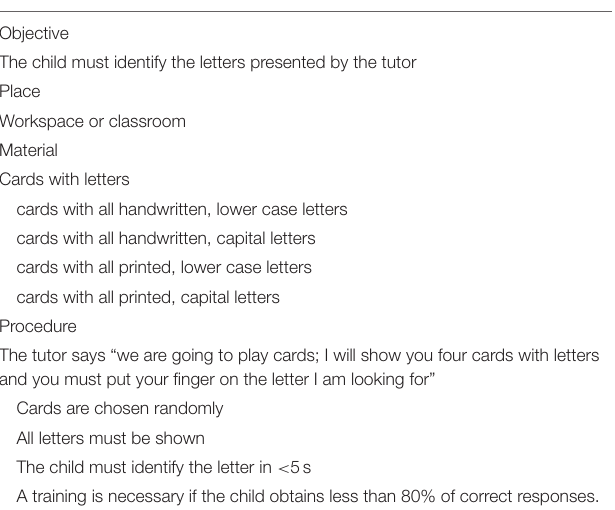
TABLE 3 | Check list: recognizing